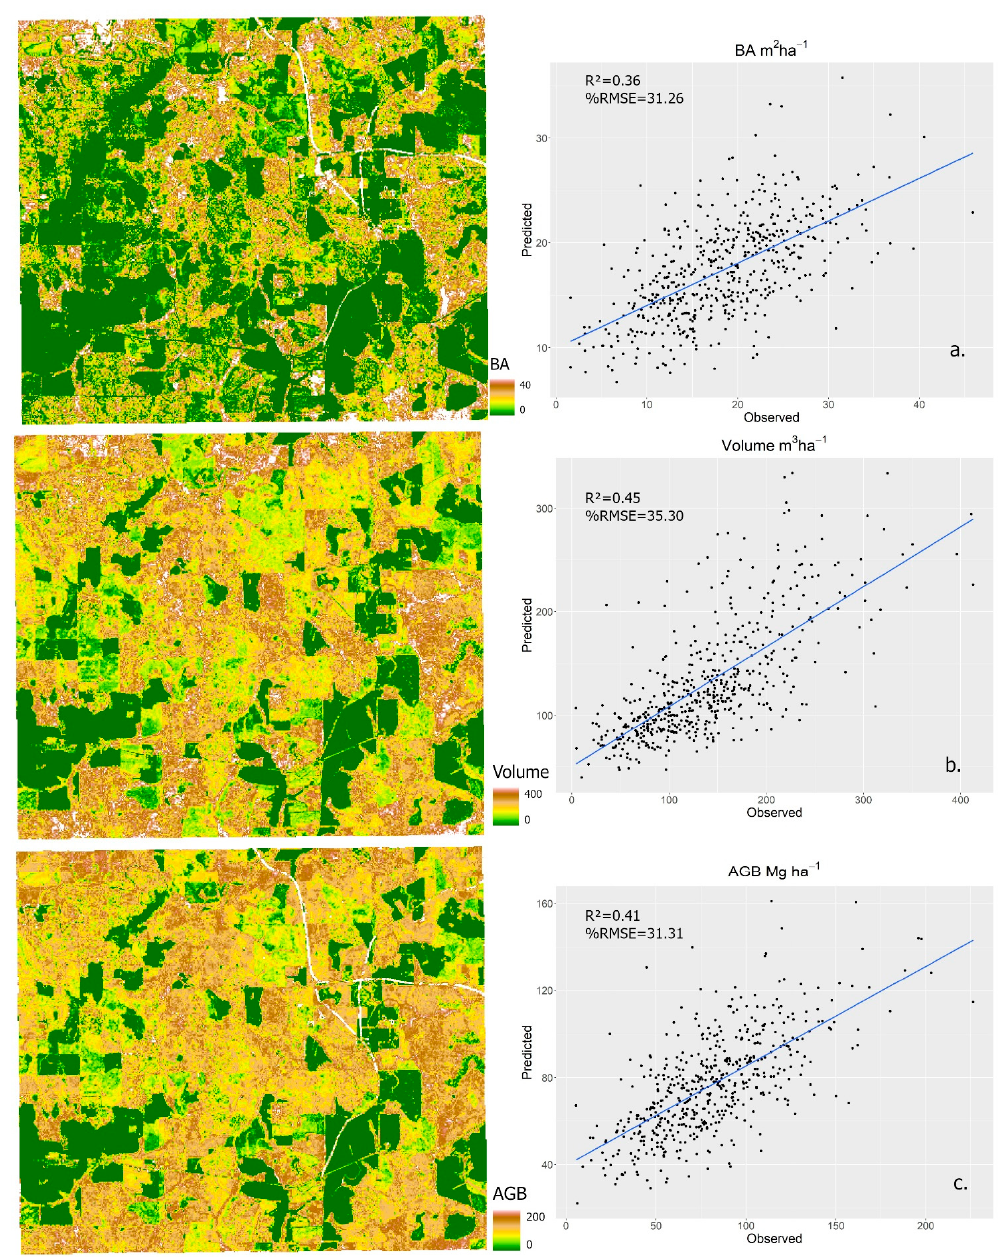
Figure 3. Predicted map outputs of BA ( a ), volume ( b ), and AGB ( c ) with scatterplot displaying correlation between observed and predicted values for the selected linear regression model.